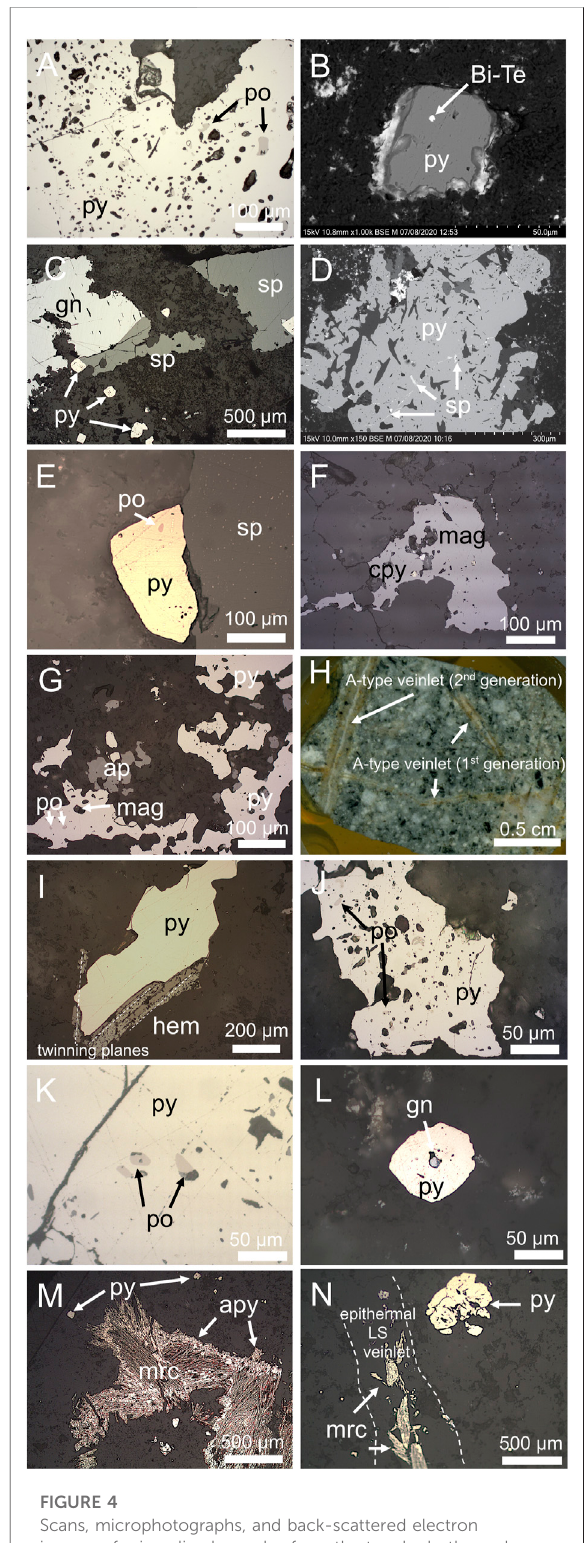
FIGURE 4 Scans, microphotographs, and back-scattered electron images of mineralized samples from the two hydrothermal systems at Kaspakas and Sardes: (A) Porous pyrite, featuring pyrrhotite from the Kaspakas sericitic altered sample LEM-1;